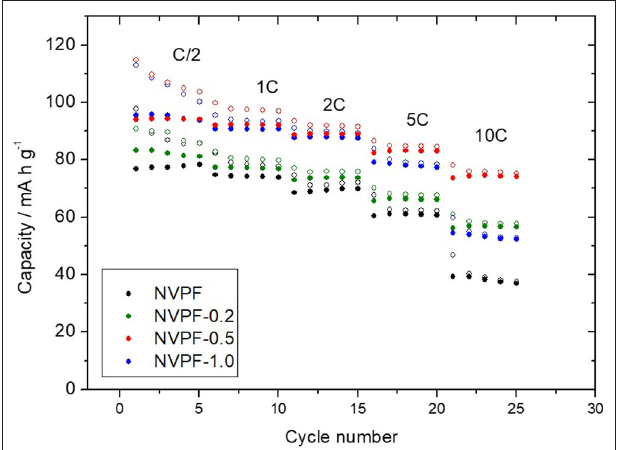
FIGURE 8 | Rate capability plot of sodium half-cells assembled with C@Na